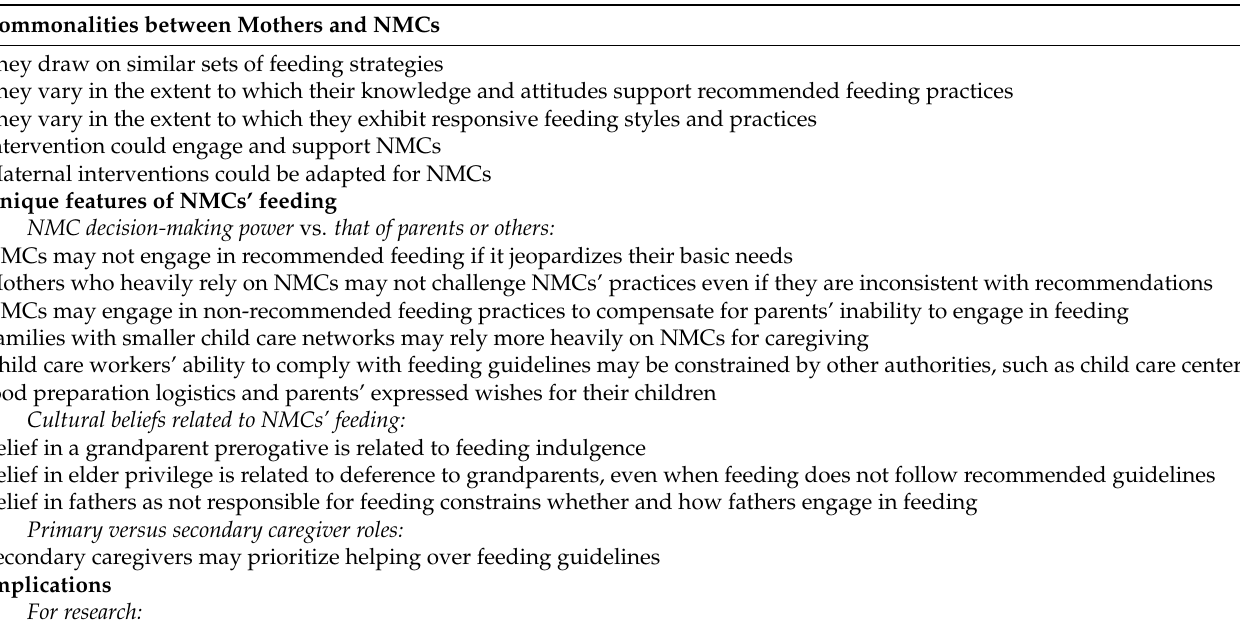
Table 3. Summary of